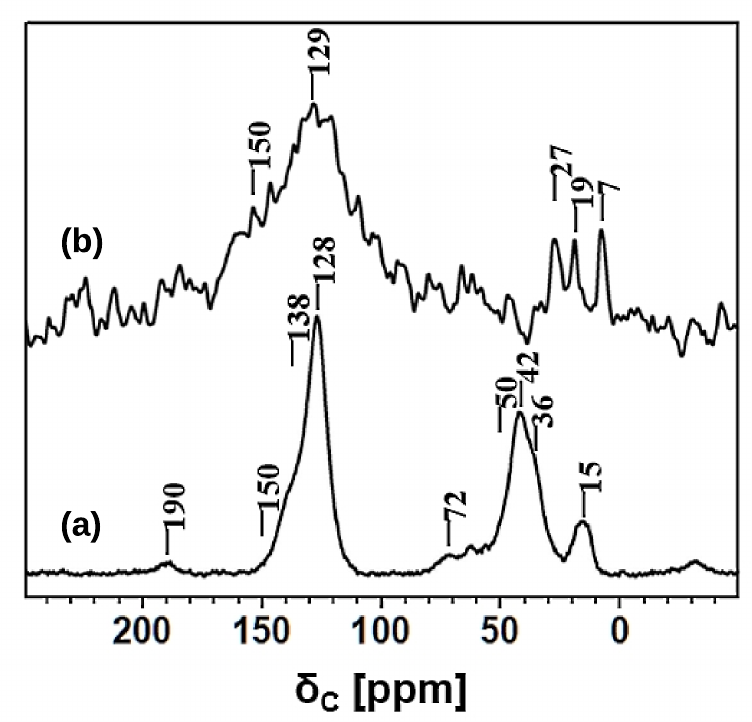
Figure 7. 13 C NMR spectra: (a) HCP-PS recorded using the CPMAS technique with a CP contact time of 0.5 ms; (b) KPS-1 recorded using the DPMAS technique with a MAS rate of 30